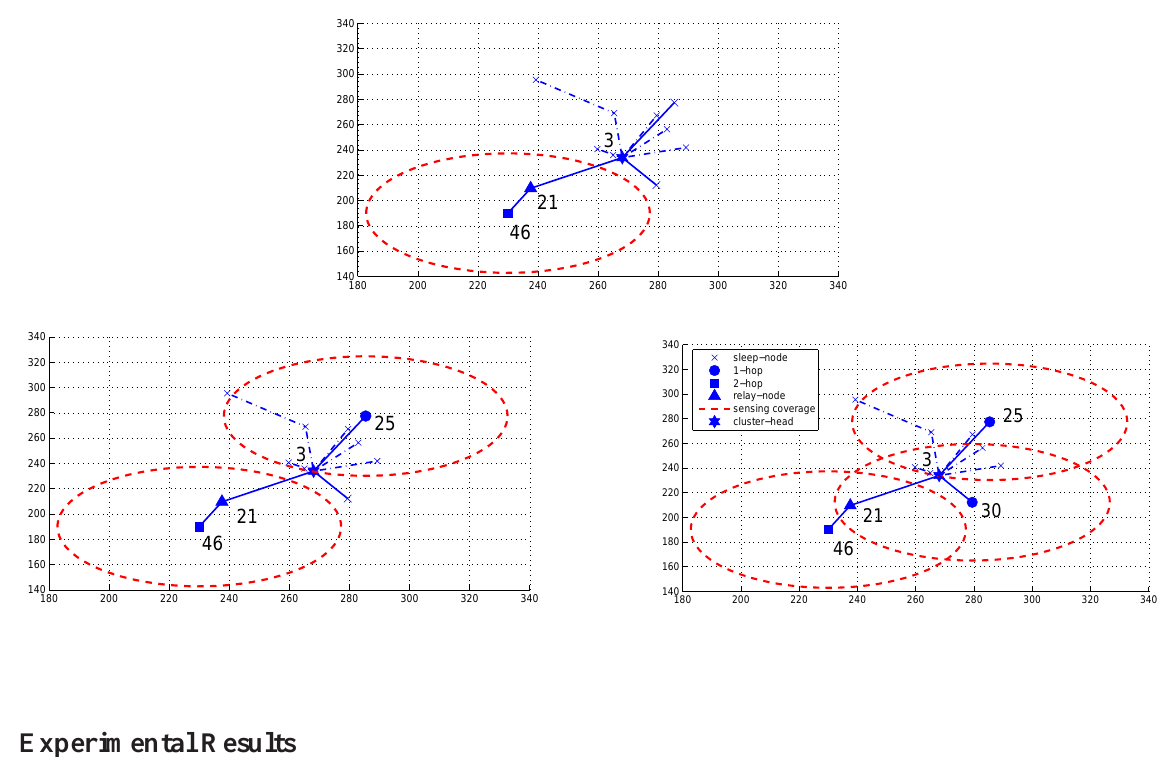
Figure 6. An example of generating a sensing round with the CASA